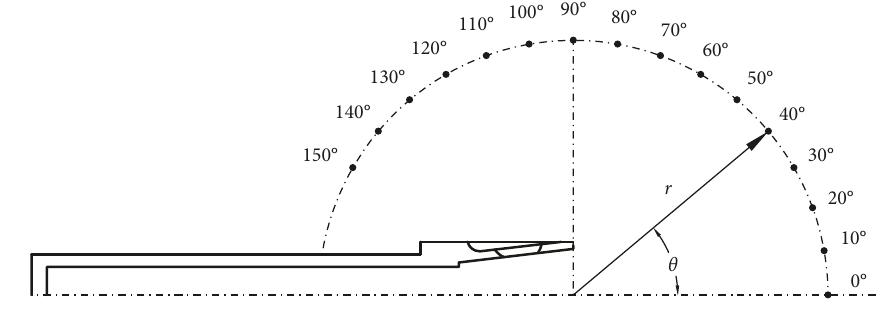
Figure 13: Receiver locations in the far